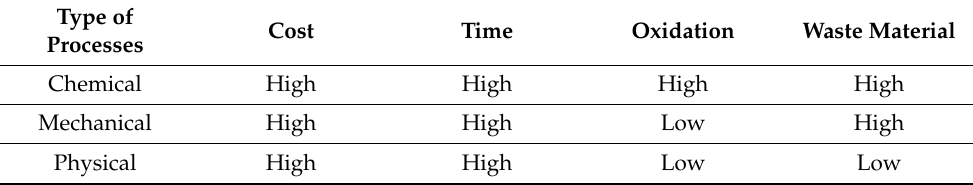
Figure 8. Different methods for generation of nanomaterials. Table 5. Comparison of nanomaterials synthesis methods [89,90].